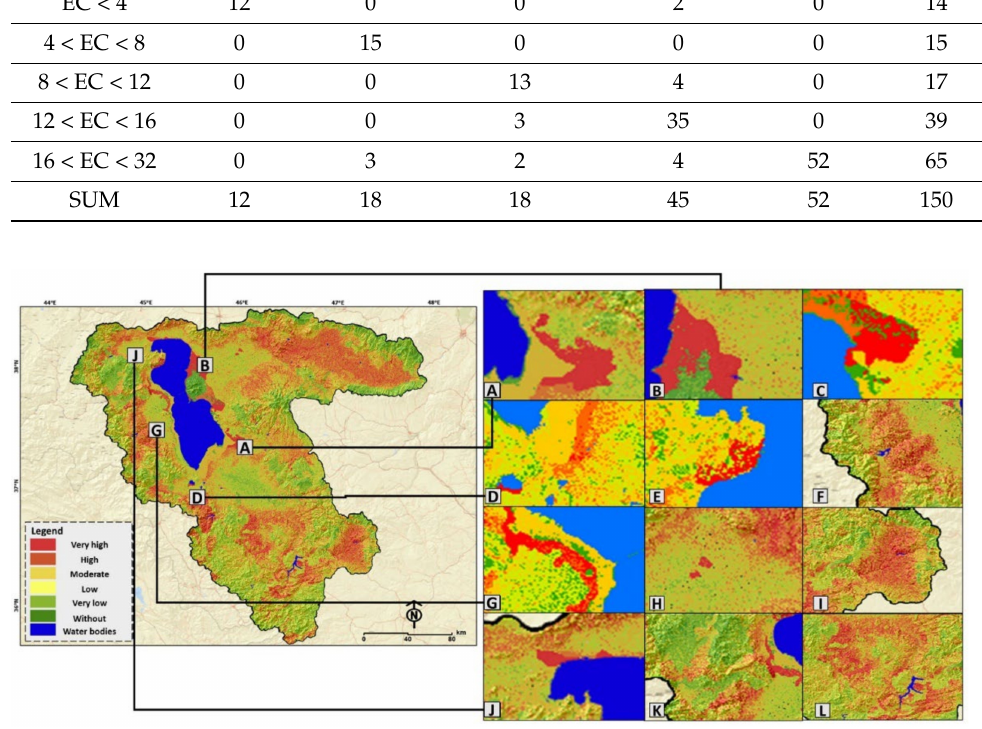
Figure 11. Enlarged views of regions affected by soil degradation risk to show details of the spatial variation of the soil degradation risk in the study area ( A , B , D , G , J ) are located around Urmia Lake and are severely affected by Urmia Lake